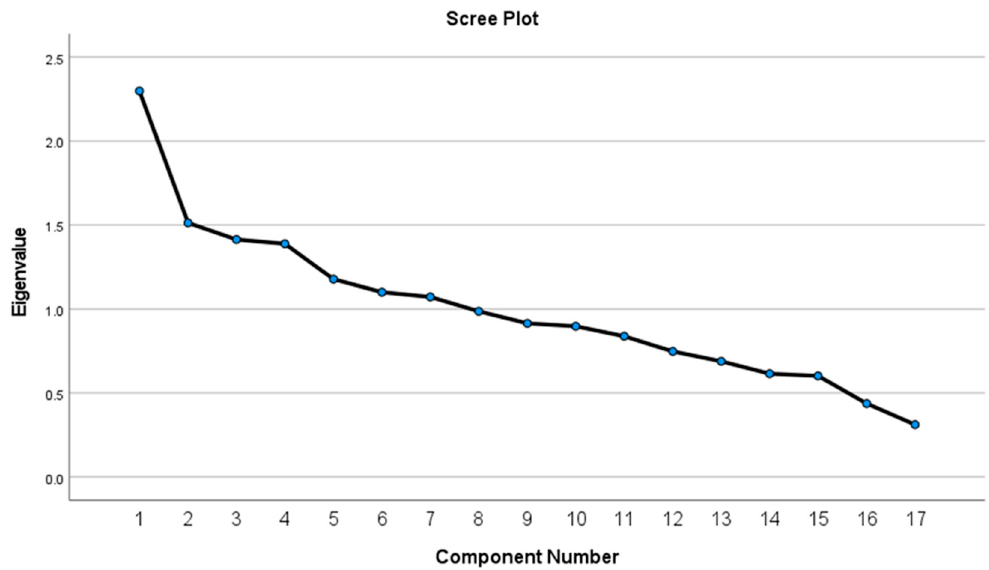
Figure 3. Scree plot displaying the eigenvalues of the food group components extracted by PCA. Table 6. Seven components extracted and retained from the